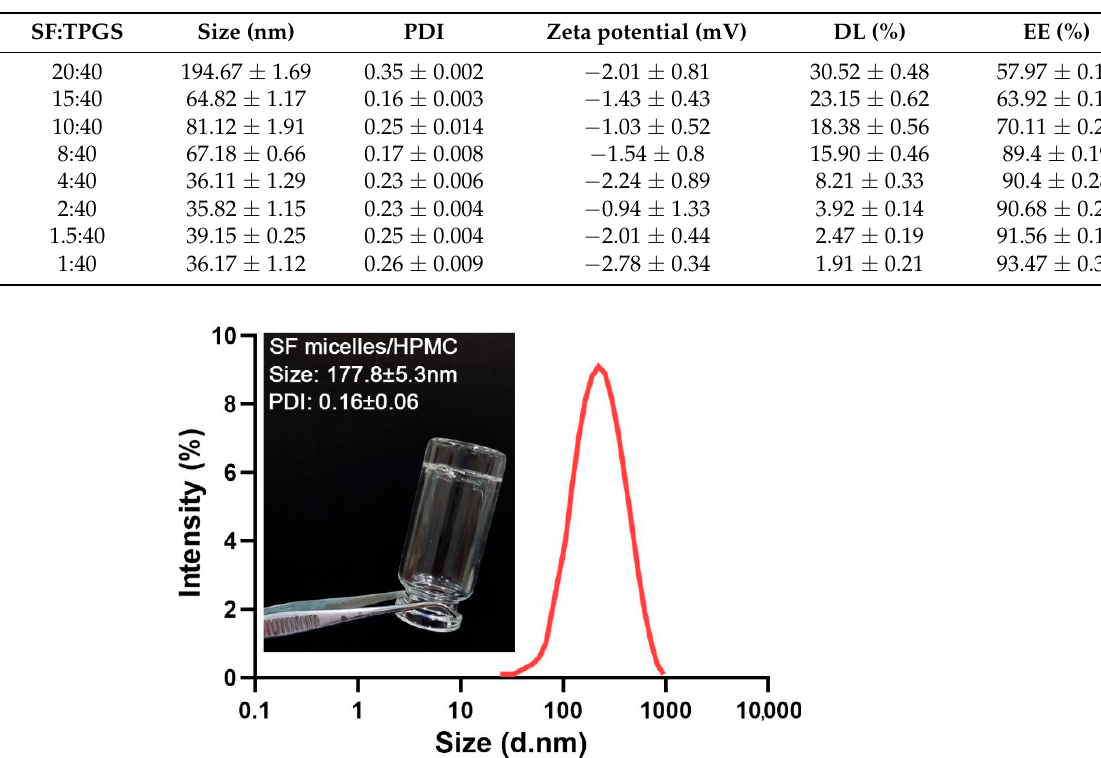
Figure A3. Ultraviolet scanning spectrum of SF,TPGS and SF micelles. Table A1. Characterization of SF micelles with different mass ratios of SF:TPGS (n = 3, mean ± SD).